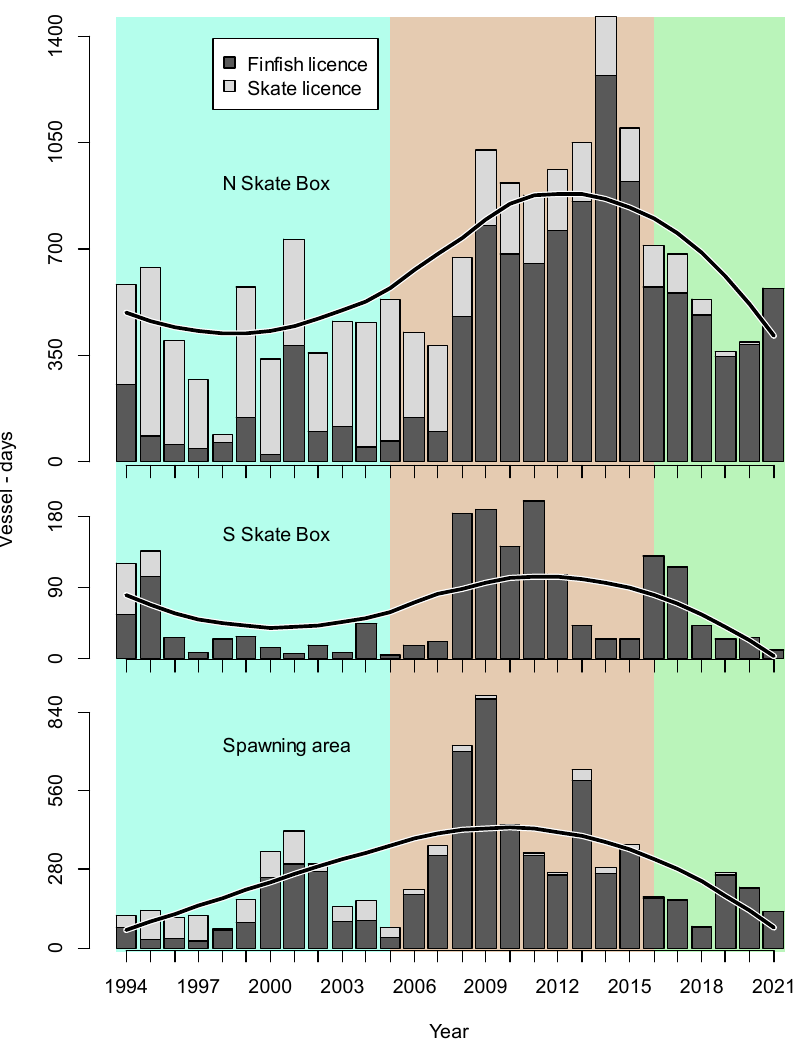
Figure 5. Fishing vessel-days per year reported in the area of the North Skate Box, South Skate Box, and shelf skate spawning area, under finfish licence and skate licences. Blue, brown, and green shaded areas: periods when the finfish assemblage and finfish catches were dominated by southern blue whiting, rock cod, and common hake, respectively. Black lines: LOESS smooth of total fishing